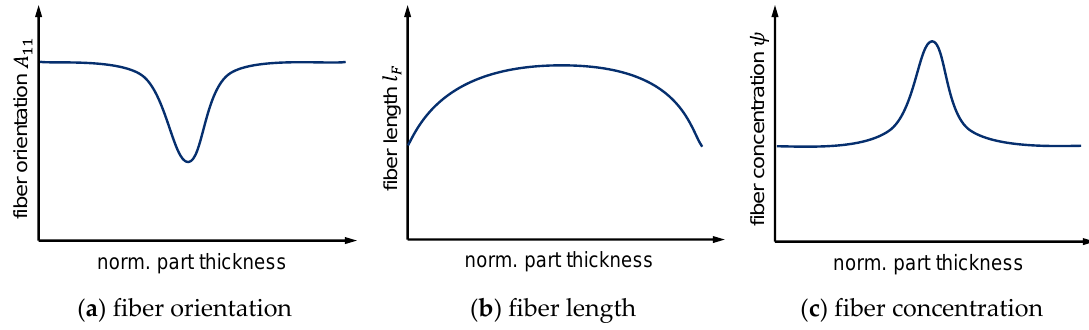
Figure 2. Velocity profile and the resulting fiber orientation distribution according to [51].